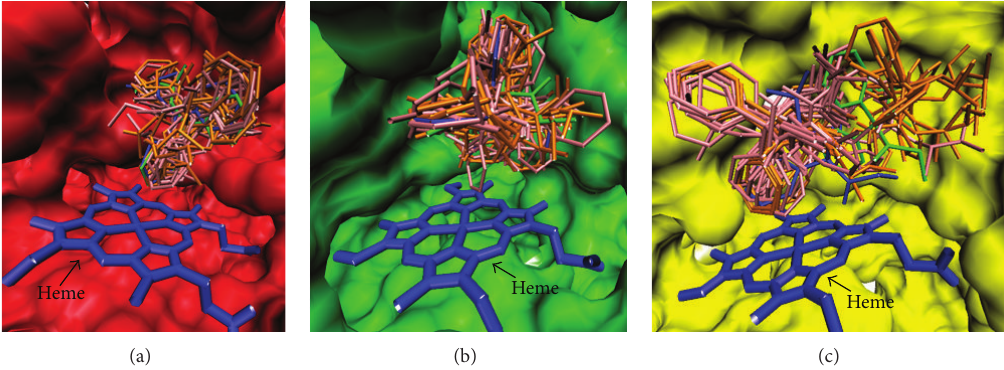
Figure 3: Docked conformations of R - and S -methadone (stick presentation) with the highest binding affinity in the alleles of (a) CYP2B6, (b) CYP2D6, and (c) CYP3A4, in the active site (red surface presentation). Pink sticks are R -methadone; orange sticks are S -methadone; blue stick is R -methadone in wild type (WT) and green stick is S -methadone in WT. Heme is in blue stick presentation. Figure was generated using VMD 1.8.7